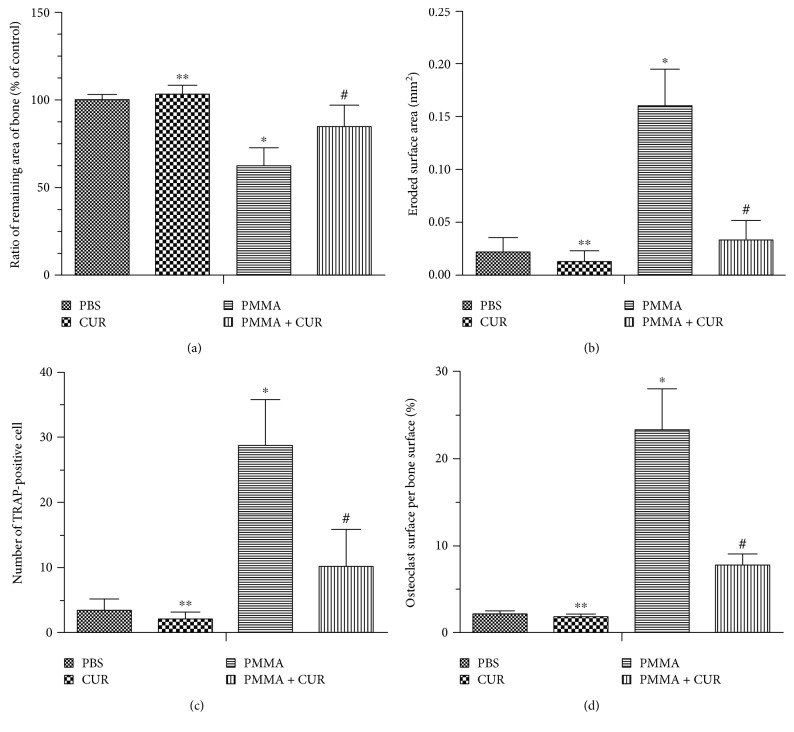
Curcumin prevented PMMA particle-induced osteoclastogenesis. Histomorphometric analysis of (a) the ratio of remaining area of bone (%), (b) the eroded surface area (mm2), (c) the number of TRAP-positive multinucleated osteoclasts, and (d) the percentage of osteoclast surface per bone surface (OcS/BS, %) within the ROI in each group (N = 6/group; ∗∗p > 0.05 versus the PBS group; ∗p < 0.001 versus the PBS group; #p < 0.01 versus the PMMA group).